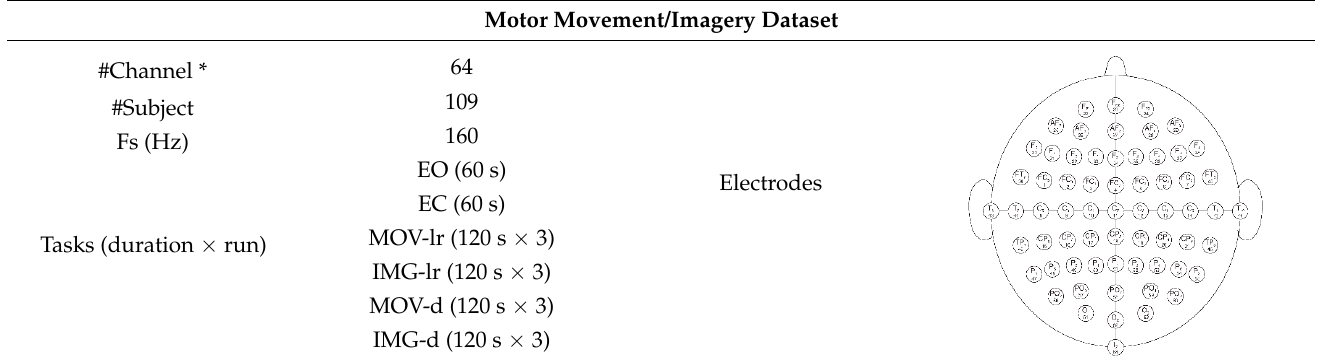
Table 1. Description of the motor movement/imagery dataset.